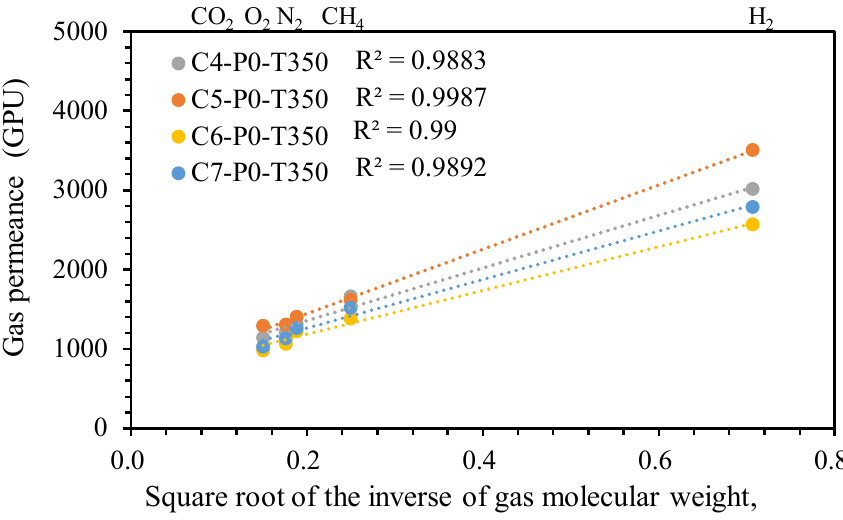
Figure 6. Single gas permeance of different gases obtained from resultant TR membranes with different precursor concentrations as a function of square root of inverse of gas molecular weights.